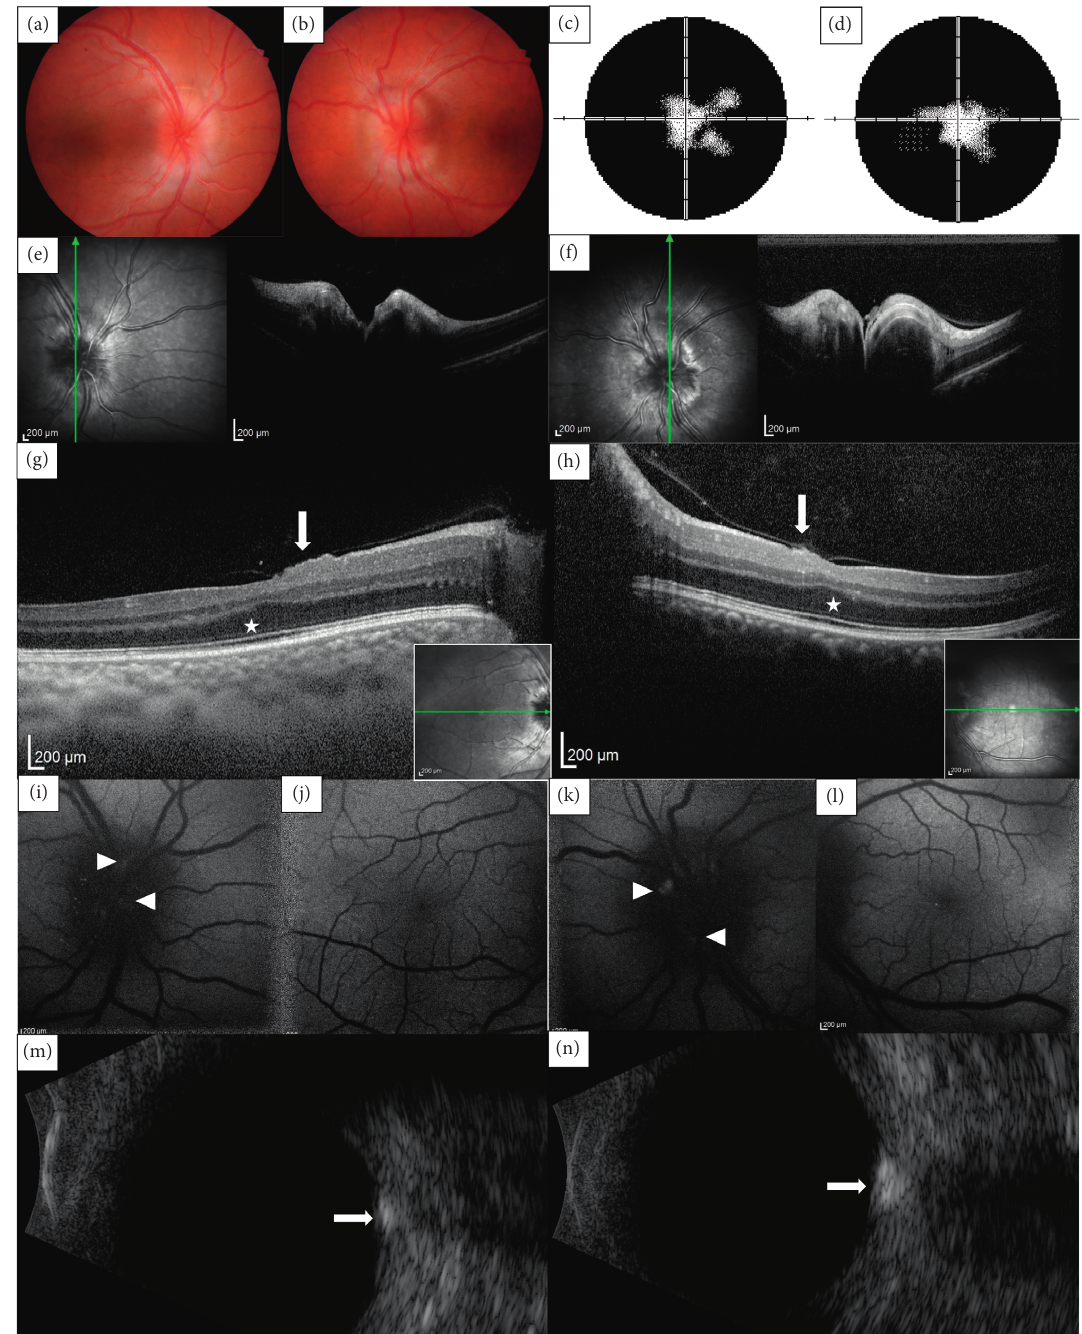
Figure 2: Posterior segment imaging in an individual with PRSS56- associated nanophthalmos. Fundus photograph of the right (a) and left (b) eye (age 11 years) abnormal optic discs with indistinct margins and no retinal pigmentary changes. Automated visual field testing within the central 50 degrees demonstrating irregular peripheral constriction in the right (c) and in the left (d) eye (age 16.5 years). Spectral domain optical coherence tomography scan of the right (e) and left (f) optic nerve heads (age 15 years), note abnormal elevation. Horizontal scans of the right (g) and left (h) macula, note absence of foveal depression and bilateral small papillomacular folds (arrows), no macular edema and thickened inner retinal and outer plexiform layers (asterisks). Autofluorescence imaging (age 16.5 years) of the right optic disc (i) and macula (j) and of the left optic disc (k) and macula (l); focal hyperfluorescence (arrowheads) suggests drusen, confirmed by B-scan ultrasonography in the right (m) and left (n) eye